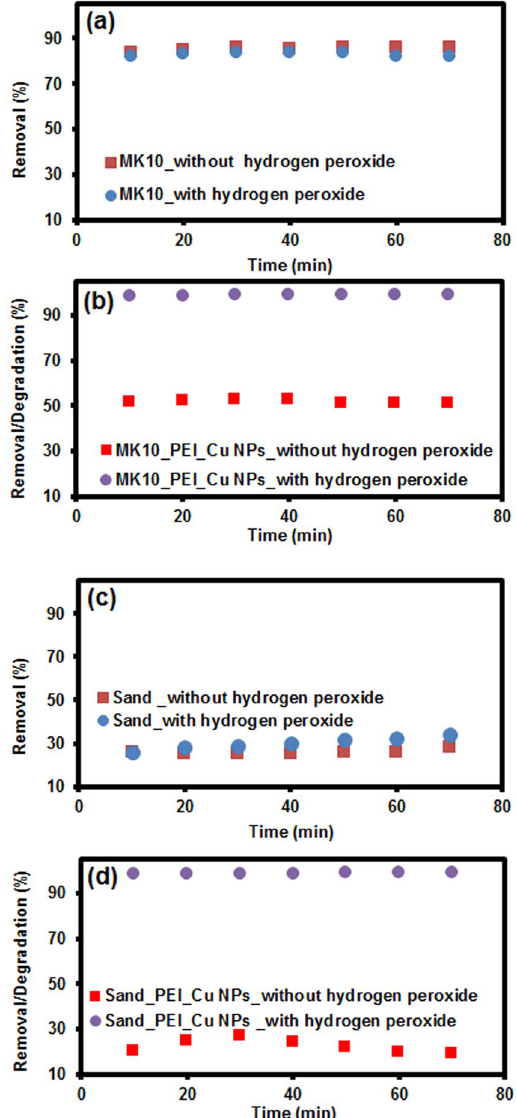
Figure 7. Atrazine degradation dynamics [adsorption/degradation] of ( a ) unmodified MK10, ( b ) modified MK10, ( c ) unmodified sand, and ( d ) modified